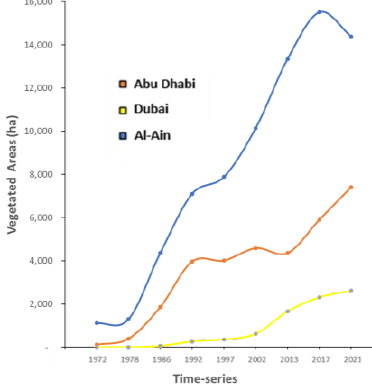
Figure 6. The growth of VEG area from 1972 to